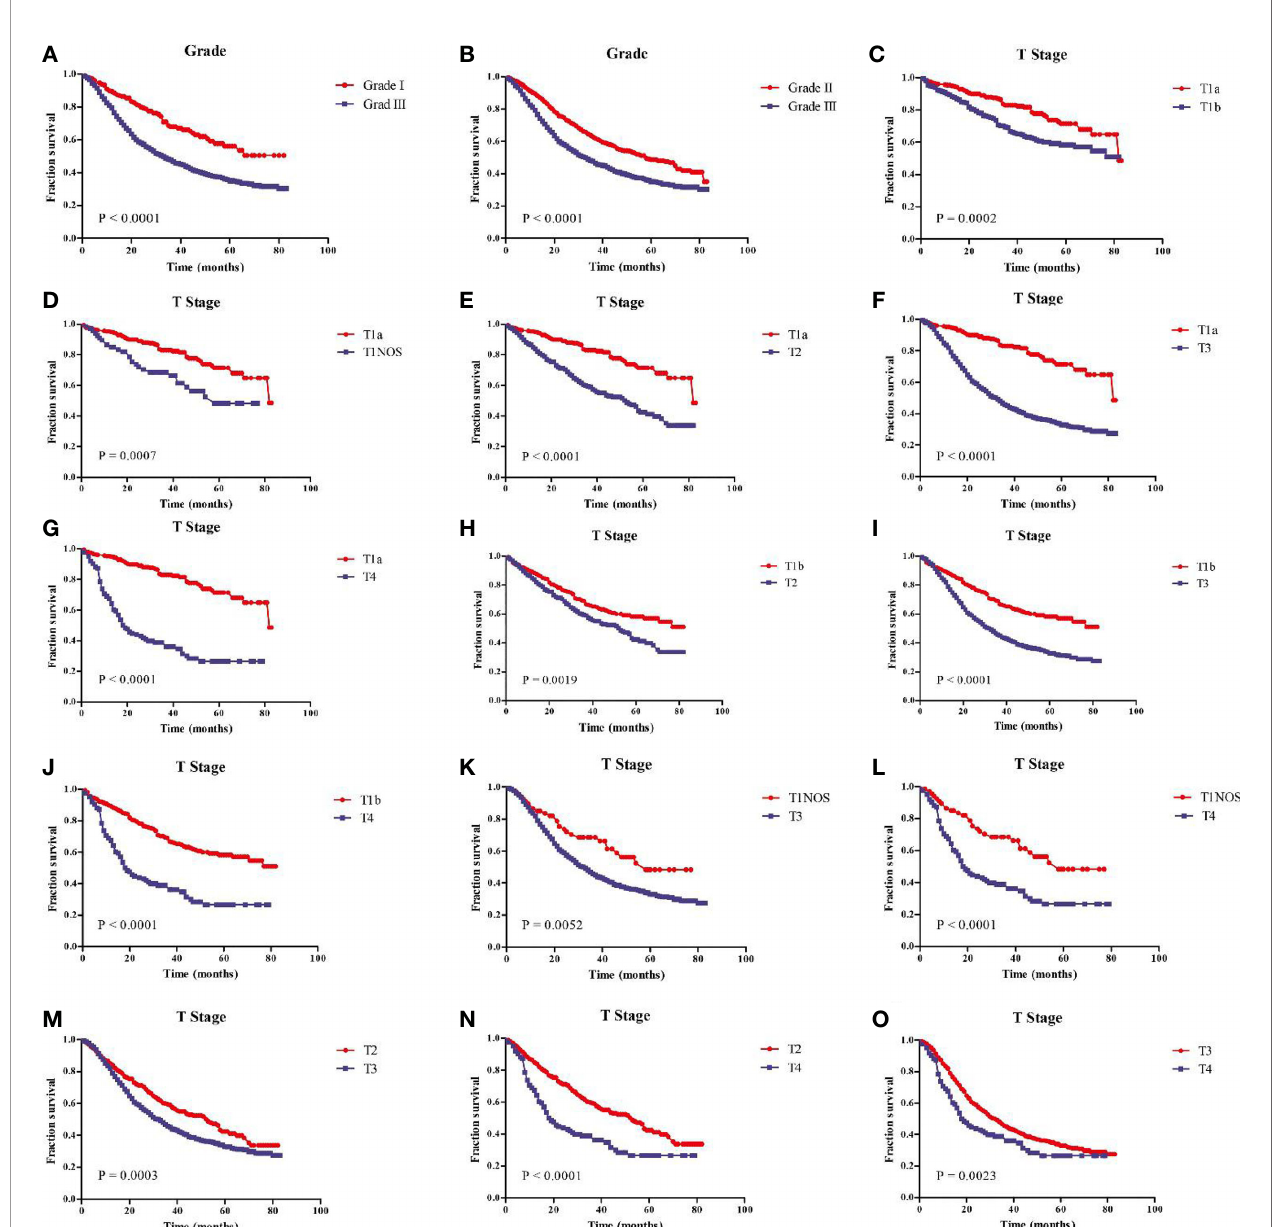
FIGURE 4 | Kaplan-Meier survival analysis showed that prognostic risk factors tumor grade and T stage of patients with GEJ cancer without distant metastasis. (A) Grade I vs. III; (B) Grade II vs. III; (C) T1a vs. T1b; (D) T1a vs. T1NOS; (E) T1a vs. T2; (F) T1a vs. T3; (G) T1a vs. T4; (H) T1b vs. T2; (I) T1b vs. T3; (J) T1b vs. T4; (K) T1NOS vs. T3; (L) T1NOS vs. T4; (M) T2 vs. T3; (N) T2 vs. T4; (O) T3 vs. T4. GEJ, Gastroesophageal Junction; T, depth of